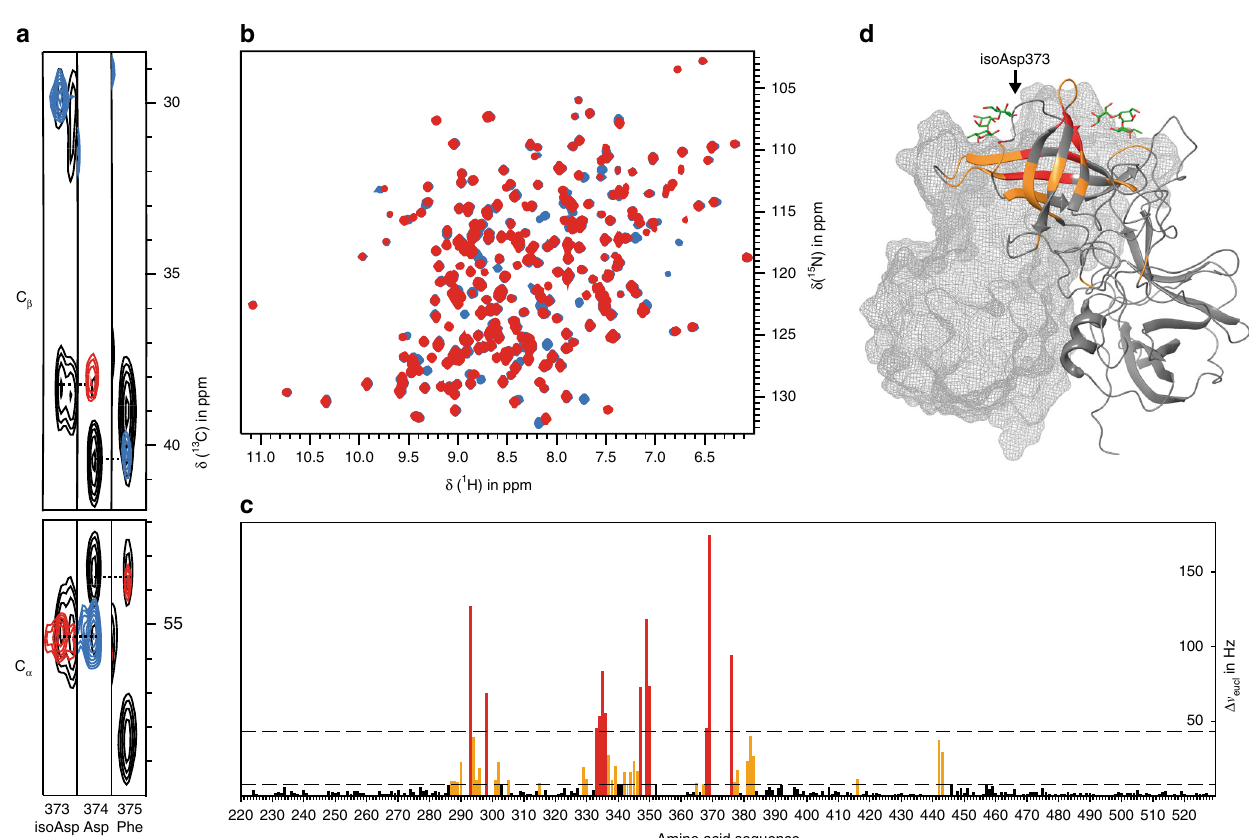
Fig. 2 Three-dimensional NMR spectra reveal deamidation of N373 and formation of isoD373. a Slices from HNCACB (black) and HN(CO)CACB spectra (red and blue) at the 1 H N and 15 N chemical shifts of isoD373, D374, and F375. The cross peak at the 13 C α chemical shift of D374 is negative (blue) showing that the peptide bond is now via the side chain of the deamidated Asn residue in position 373 yielding an iso-Asp (isoD373). b 1 H, 15 N TROSY HSQC of native Saga P-dimers (red) and deamidated, post-translationally modi fi ed Saga P-dimers (blue). c Chemical shift perturbations (CSPs) induced by irreversible deamidation of N373 with dashed lines at 2 σ (red color) and at the experimentally determined signi fi cance threshold of 7.9 Hz (orange color, see Supplementary Note 2 and Supplementary Fig. 11 for details). d CSPs mapped onto the crystal structure of P-dimers complexed with B trisaccharide